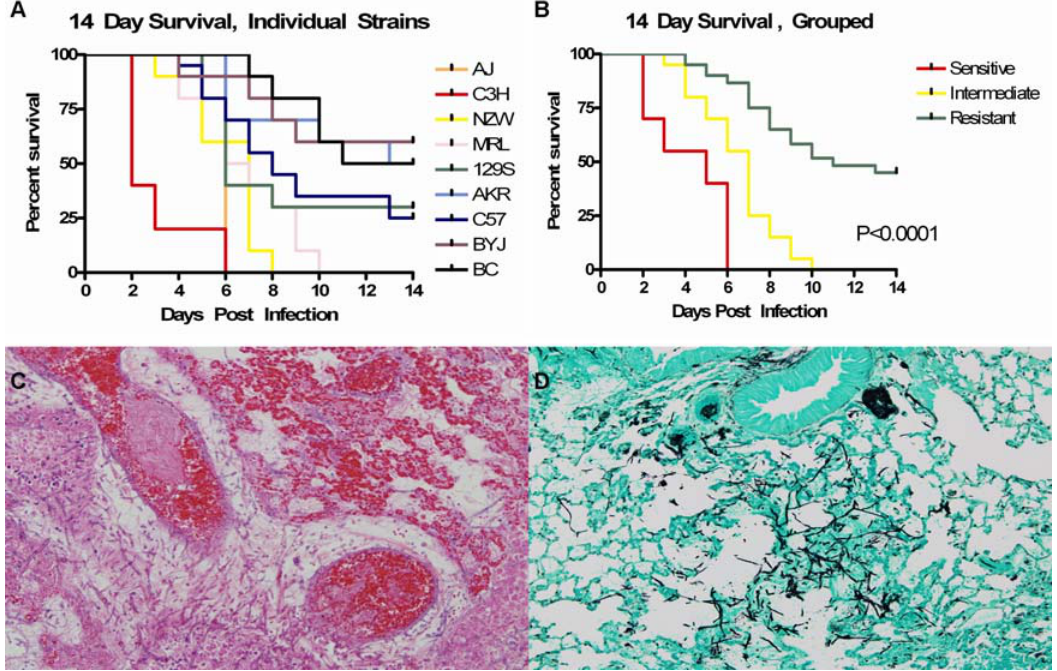
Figure 1. Survival following immune suppression and inhalation of A.fumigatus differs among inbred strains of mice. (A) 14-day survival phenotype for inbred murine strains following immunosuppression and inhalation of 3.0 6 10 8 AF293 conidia. Susceptible strains had death of all mice by day 6 following infection. Intermediate strains had death predominately during neutrophil recovery (days 8–11) and resistant strains had surviving mice at day 14. N=10 mice per strain. Repetitions of the inhalation in C57Bl/6, Balb/C, A/J and C3H/HeJ yielded similar results, indicating reproducibility of phenotype and consistency of inhalational protocol. (B) Kaplan-Meier curve representing divergent outcomes of murine strains following immune suppression and inhalation of A. fumigatus . Death occurred earlier in susceptible mice as compared to intermediate and resistant